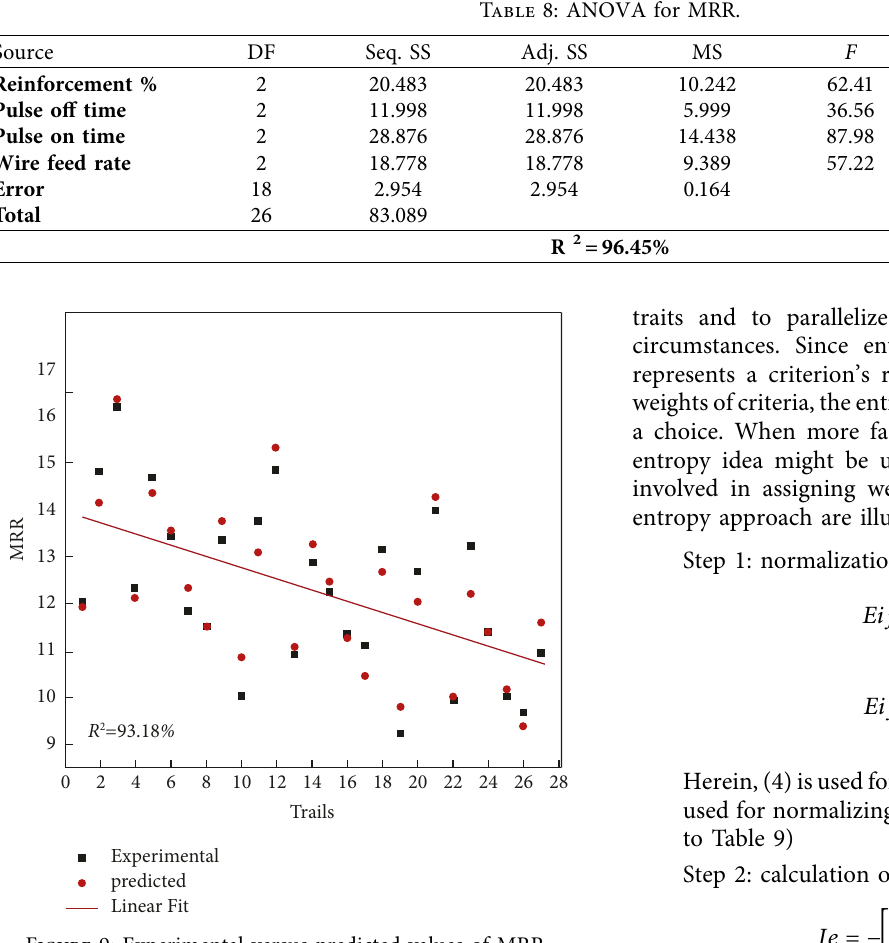
Figure 9: Experimental versus predicted values of